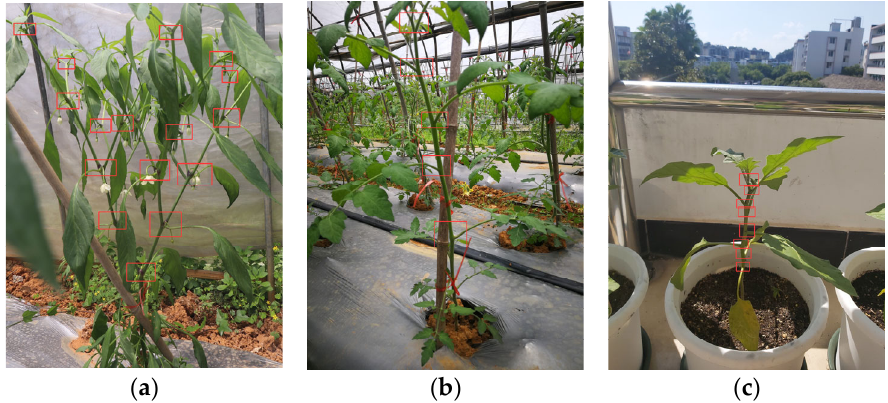
Figure 10. Examples of detected node results. ( a ) Chili; ( b ) tomato; ( c ) eggplant.